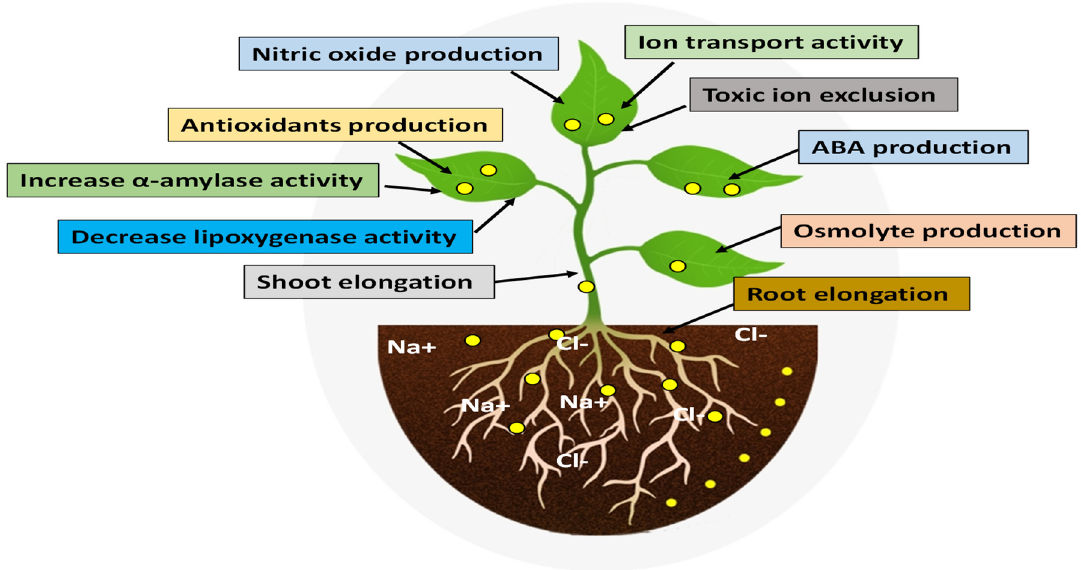
Figure 3. Nanomaterials can help plants mitigate the negative effect of